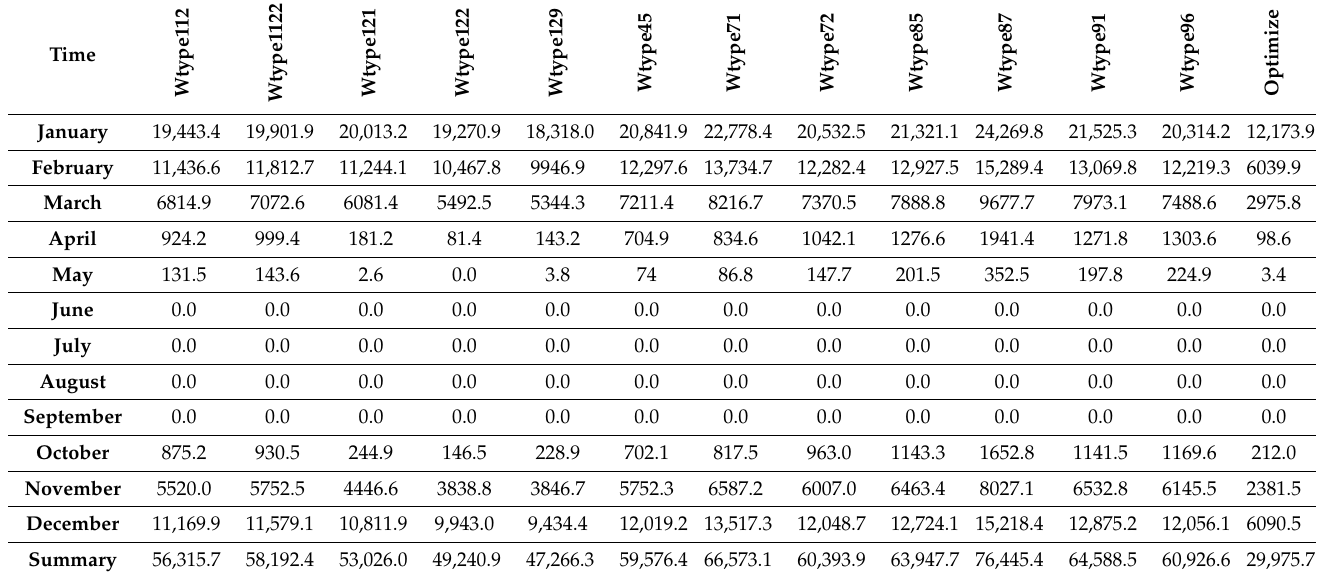
Table 2. Monthly average requirement heating (MJ) in the optimized model and types of conventional passive solar